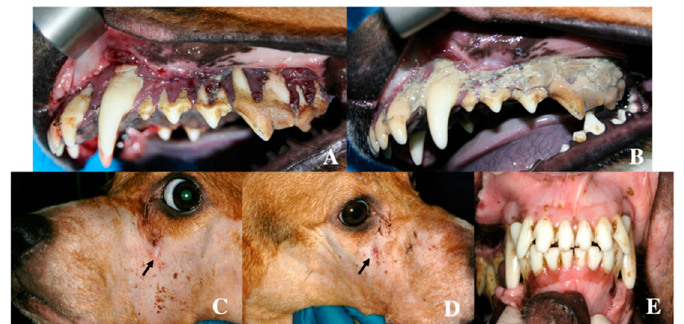
Figure 3. Postoperative clinical photographs after two weeks and 12 weeks. ( A ) wound dehiscence after two weeks; ( B ) inflammatory symptoms after 12 weeks; ( C ) and ( D ) fistula formation at infraorbital area (arrow: fistula); ( E ) stable occlusion after 12 weeks.